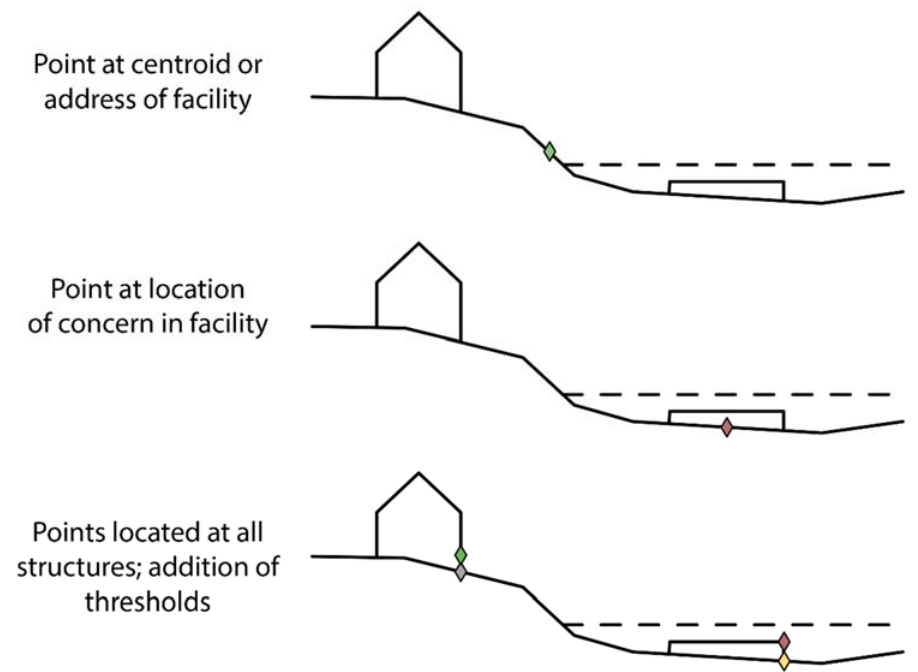
Figure 12. Implications of point location. Points used without verifying location in relationship to a vulnerability risk the creation of misleading results. While this may be less of a problem at geographic scales, specific impact assessments require specific data regarding individual